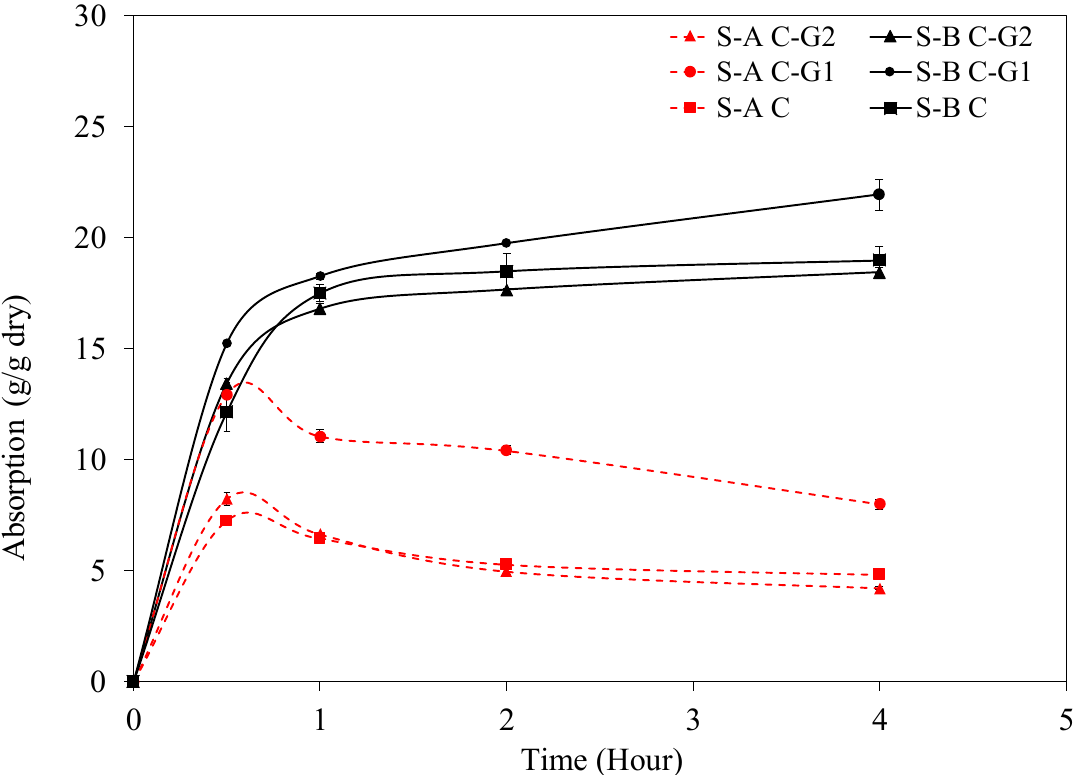
Figure 1. Absorption behavior of S-A and S-B in neat cement slurry, C, and in slurries with glass. powders, C-G1 and C-G2.